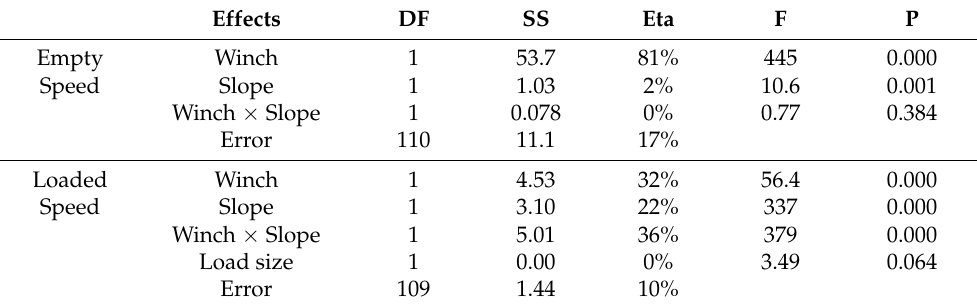
Table 4. Results of the GLM analysis for the travel speed.